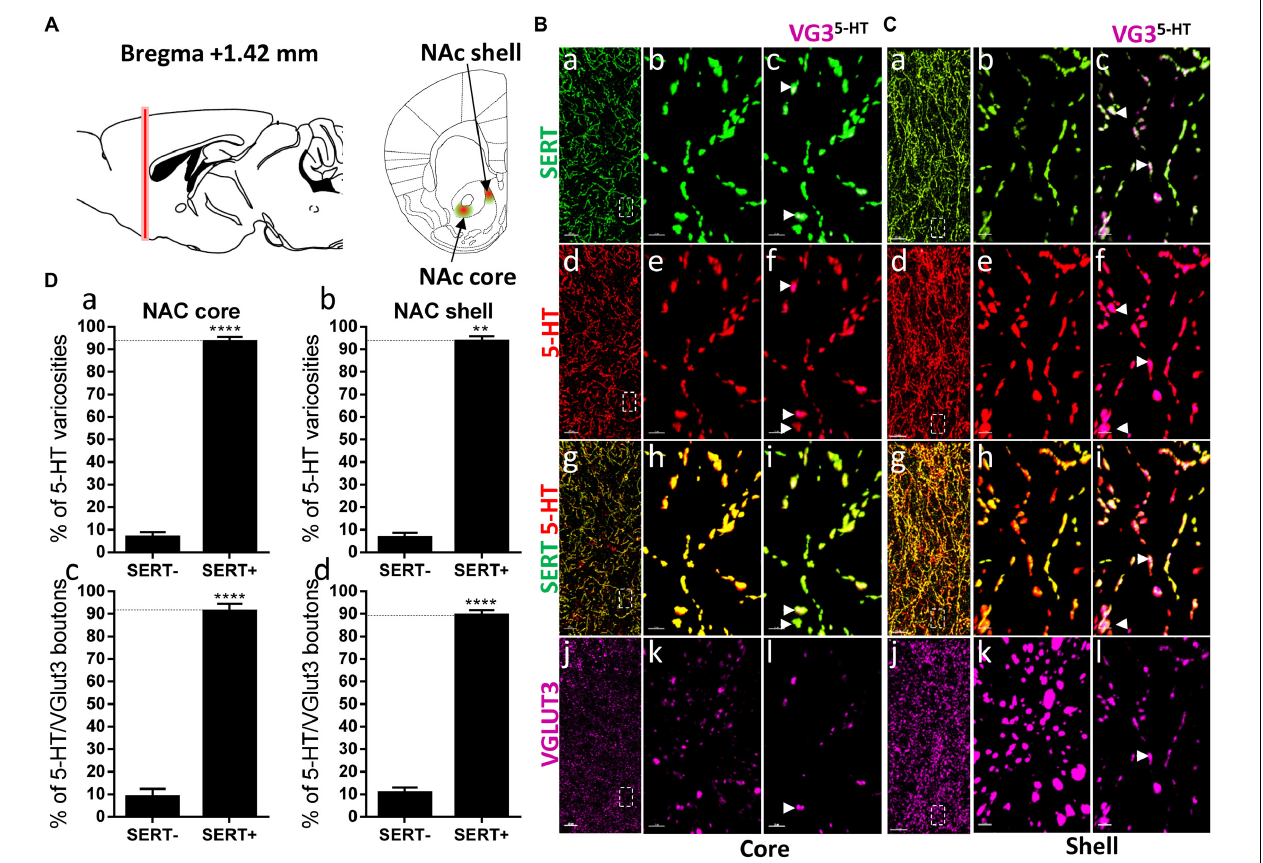
FIGURE 2 | Distribution of VGLUT3 + boutons within 5-HT + and SERT + axons in the nucleus accumbens. (A) Schematic drawing showing the location of the acquired micrographs. Nucleus accumbens (NAc) mosaic images were acquired at bregma + 1.42 ± 0.2 mm (red vertical line) in the dorsomedial shell and the core (ventrolateral to the anterior commissure) of the nucleus accumbens (green/red areas). (B) Micrograph showing the distribution of the SERT (green, a–c ), 5-HT (red, d–f ), SERT (green) + 5-HT (red) ( g–i ), and VGLUT3 (magenta, j–l ) in the NAc core. Left panel (a,d,g,j) shows lower magnification. Scale bar: 50 µ m. Middle (b,e,h,k) and right (c,f,i,l) panels show higher magnification of the white dashed box in the left panel (a,d,g,j) . Scale bar: 2 µ m. The right panel shows the VGLUT3 boutons co-labeled with SERT (c) , 5-HT (f) , and SERT + 5-HT (i) . VGLUT3 puncta located within 5-HT varicosities were isolated using Imaris (l) . Arrowheads show 5-HT varicosities collocated with SERT and VGLUT3 (c,f,i,l) . (C) Micrograph showing the distribution of the SERT (green, a–c ), 5-HT (red, d–f ), SERT (green) + 5-HT (red) ( g–i ), and VGLUT3 (magenta, j–l ) in the Nac shell. Left panel (a,d,g,j) shows lower magnification. Scale bar: 50 µ m. Middle (b,e,h,k) and right (c,f,I,l) panels show higher magnification of the white dashed box in the left panel (a,d,g,j) . Scale bar: 2 µ m. The right panel shows the VGLUT3 boutons co-labeled with SERT (c) , 5-HT (f) , and SERT + 5-HT (i) . VGLUT3 puncta located within 5-HT varicosities were isolated using Imaris (l) . Arrowheads show 5-HT varicosities collocated with